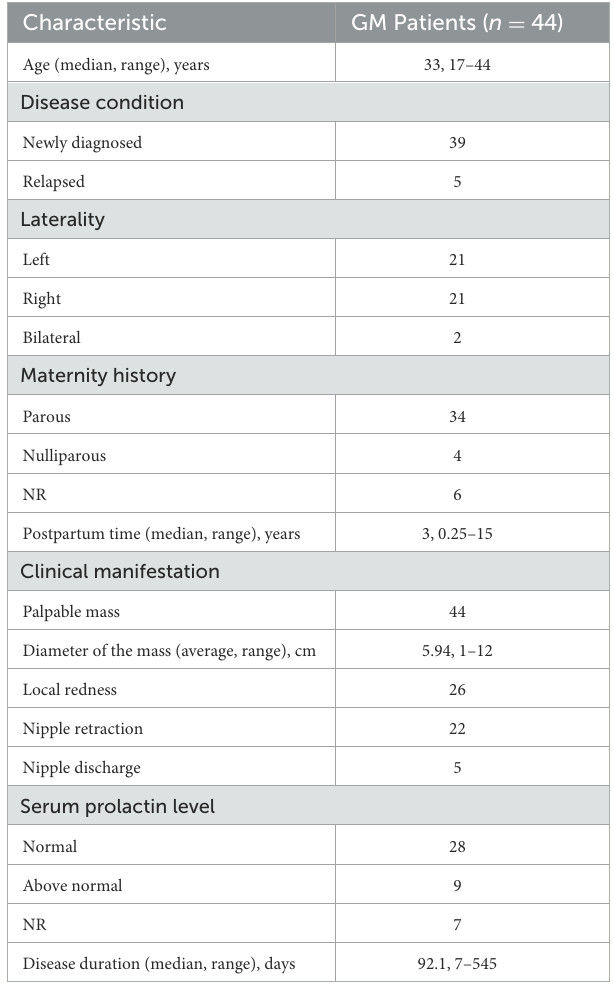
TABLE 1 Clinical characteristics of GM